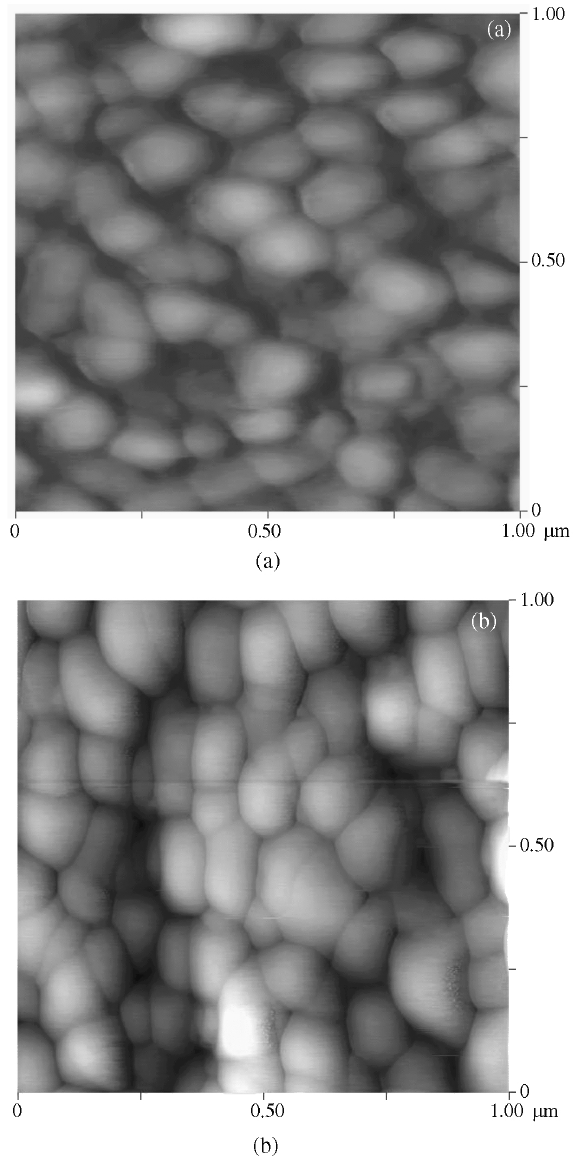
Figure 4. AFM images of (a) SBT film treated at 800 °C for 2 h; (b) SBN film treated at 700 °C for 2 h.